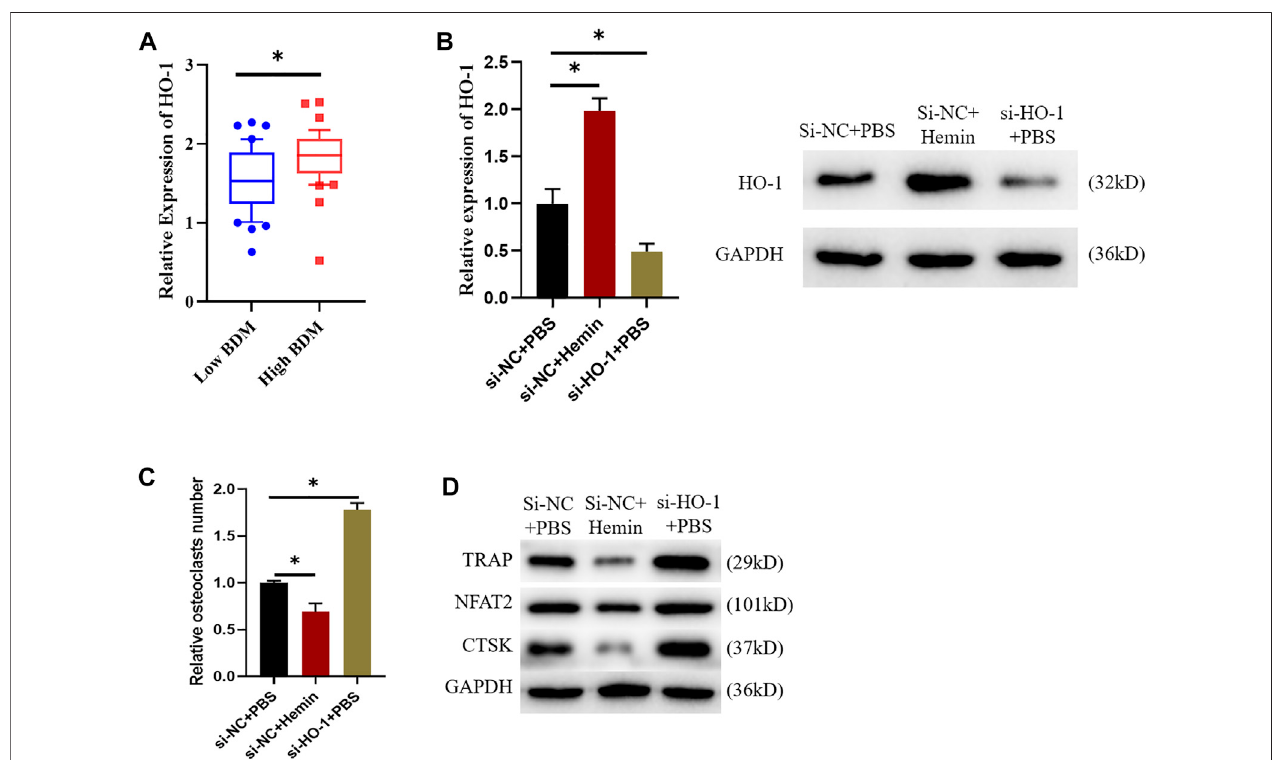
FIGURE1| HO-1cansuppressosteoclastdifferentiation. (A) DifferencesinHO-1expressionlevelbetweenlowandhighBDMfemale. (B) ChangesofHO-1mRNA and protein expression levels after si-HO-1 and hemin treatment. (C) TRAP staining shows that HO-1 could affect osteoclast differentiation. (D) Changes of expression levels of proteins related to osteoclast differentiation after HO-1 silencing and hemin treatment. * p <